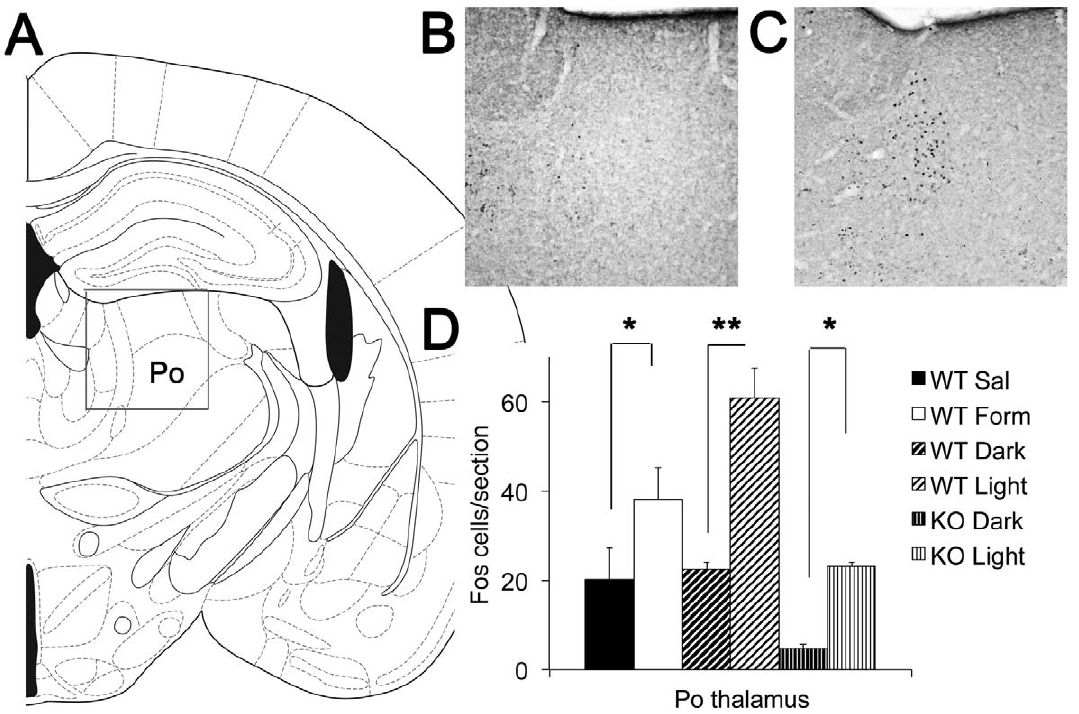
Figure 4. Light activates neurons in the posterior thalamic group. (A) Line drawing indicating the region of interest within the adult thalamus, which encompasses a group of nuclei that we refer to here as the posterior thalamic group (Po – see Methods). The boxed outline indicates the region of the thalamus shown in the micrographs to the right. (B) An example of Fos expression in a sham-treated P8 mouse pup that remained in the dark (WT Dark). (C) An example of Fos expression in a P8 mouse pup exposed to light for 30 min (WT Light). (D) Quantification of the number of Fos expressing neurons in Po. In WT pups, light increased the density of Fos cells 3 fold (Dark n=8 and Light n=9). Formalin injection increased the density of Fos stained cells by 1.9-fold compared to saline injections (n=4 both saline and formalin groups). In KO pups, light increased Fos staining (KO Dark n=5, KO Light n=9). Data are presented as means of the average number of Fos staining neurons per section in each animal 6 SEM. Asterisks indicate (*) p , 0.05 and (**) p , 0.001,